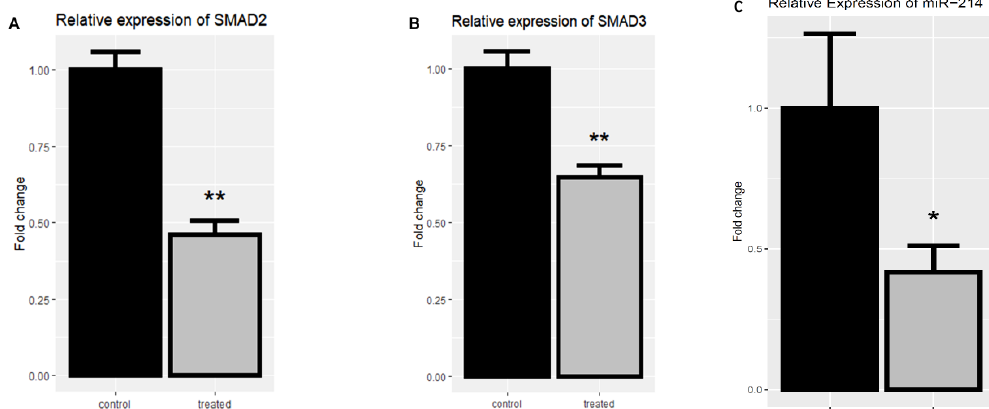
Figure 6. The relative mRNA expression of SMAD2 and SMAD3 after the treatment with 17.7 µg/mL rCTII in the SK-MEL-3 cell line ( A , B ). The expression level of miR-214 after the treatment with rCTII ( C ). The expression of candidate genes was assessed through real-time PCR in the control and treated group. Our result demonstrated that for the rCTII protein, the SMAD2 and SMAD3 expression levels were evaluated in the treated and untreated cell line to investigate the rCTII effect on the transforming growth factor-beta (TGF-β) signaling pathway. After melanoma cells were treated with rCTII, there was a significant down-regulation in the expression level of SMAD2 and SMAD3 compared to untreated melanoma cells (both p < 0.01). Subsequent to cancerous cells being treated with rCTII, there was a significant reduction in the expression level of miR-214 compared to untreated melanoma cells ( p < 0.05). Error bars display the ± SD. The independent t -tests assessed the p -values. p < 0.05 (*), p < 0.01 (**).